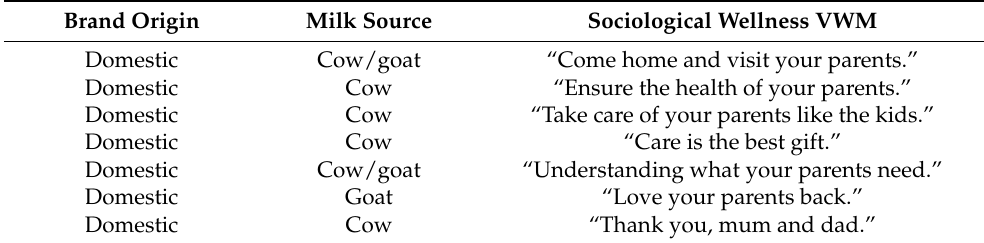
Table 5. Verbatim of all instances of sociological wellness voluntary well-being messaging (VWM) about family. Brand Origin Milk Source Sociological Wellness VWM Domestic Cow/goat “Come home and visit your parents.” Domestic Cow “Ensure the health of your parents.” Domestic Cow “Take care of your parents like the kids.” Domestic Cow “Care is the best gift.” Domestic Cow/goat “Understanding what your parents need.” Domestic Goat “Love your parents back.” Domestic